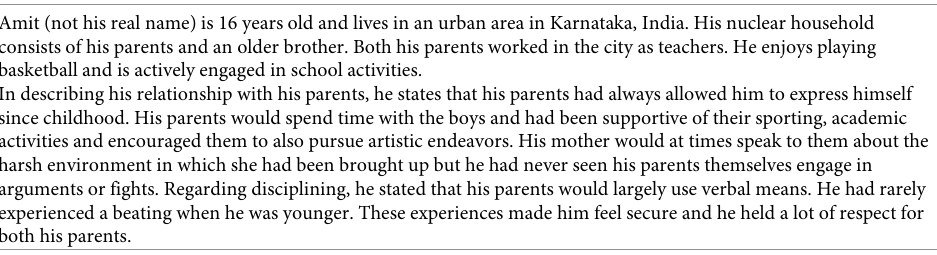
Table 5. Case study– 2 perspective of an adolescent whose mother had experienced harsh